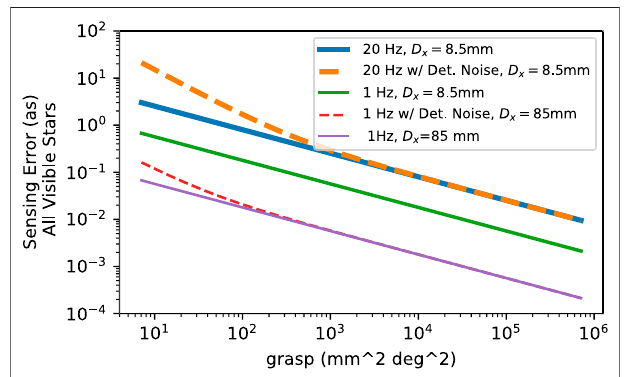
FIGURE6| Attitudesensinglimitcurvesassumingcentroidingnoisedue to photon statistics and detector noise from the TRL-9 MT9P031 CMOS detectorswidelyusedonnanosatellites.Foran85-mmspacetelescope,sub- arcsec sensing is readily achieved at 100 s sampling or slower rates, implying that ∼ 10-Hz bandwidth controllers are as fast as is feasible on dim